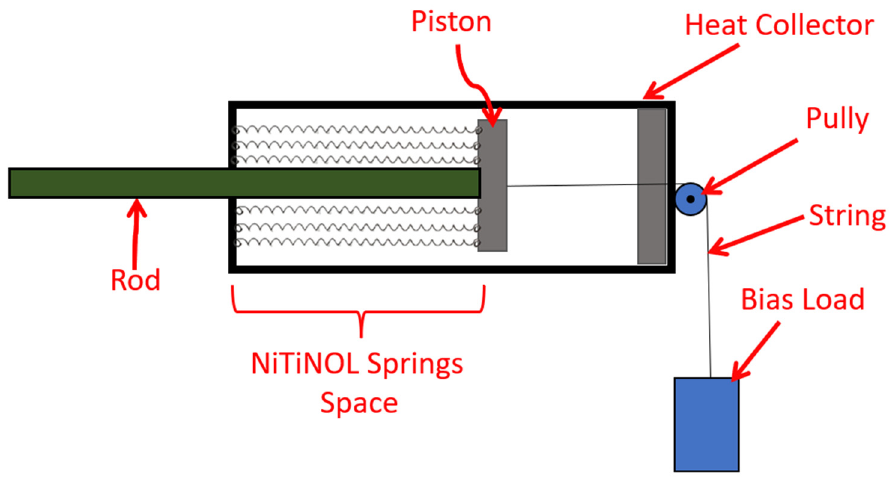
Figure 1. Conceptual design model for the solar-driven thermomechanical SMA actuator.